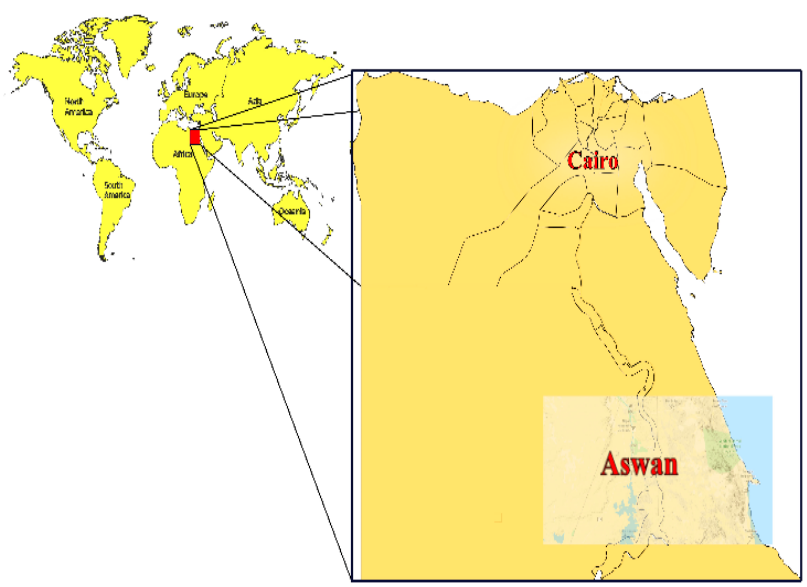
Figure 4. Location of the case study (Aswan) on the world map.